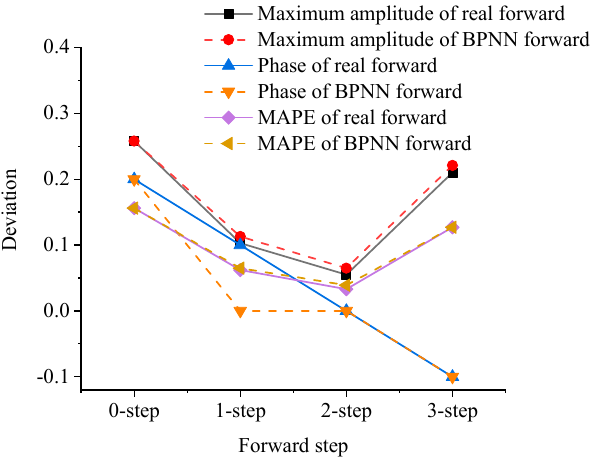
Figure 10. Comparison of the deviation between actual-data and prediction feedforward control (sinusoidal signal).